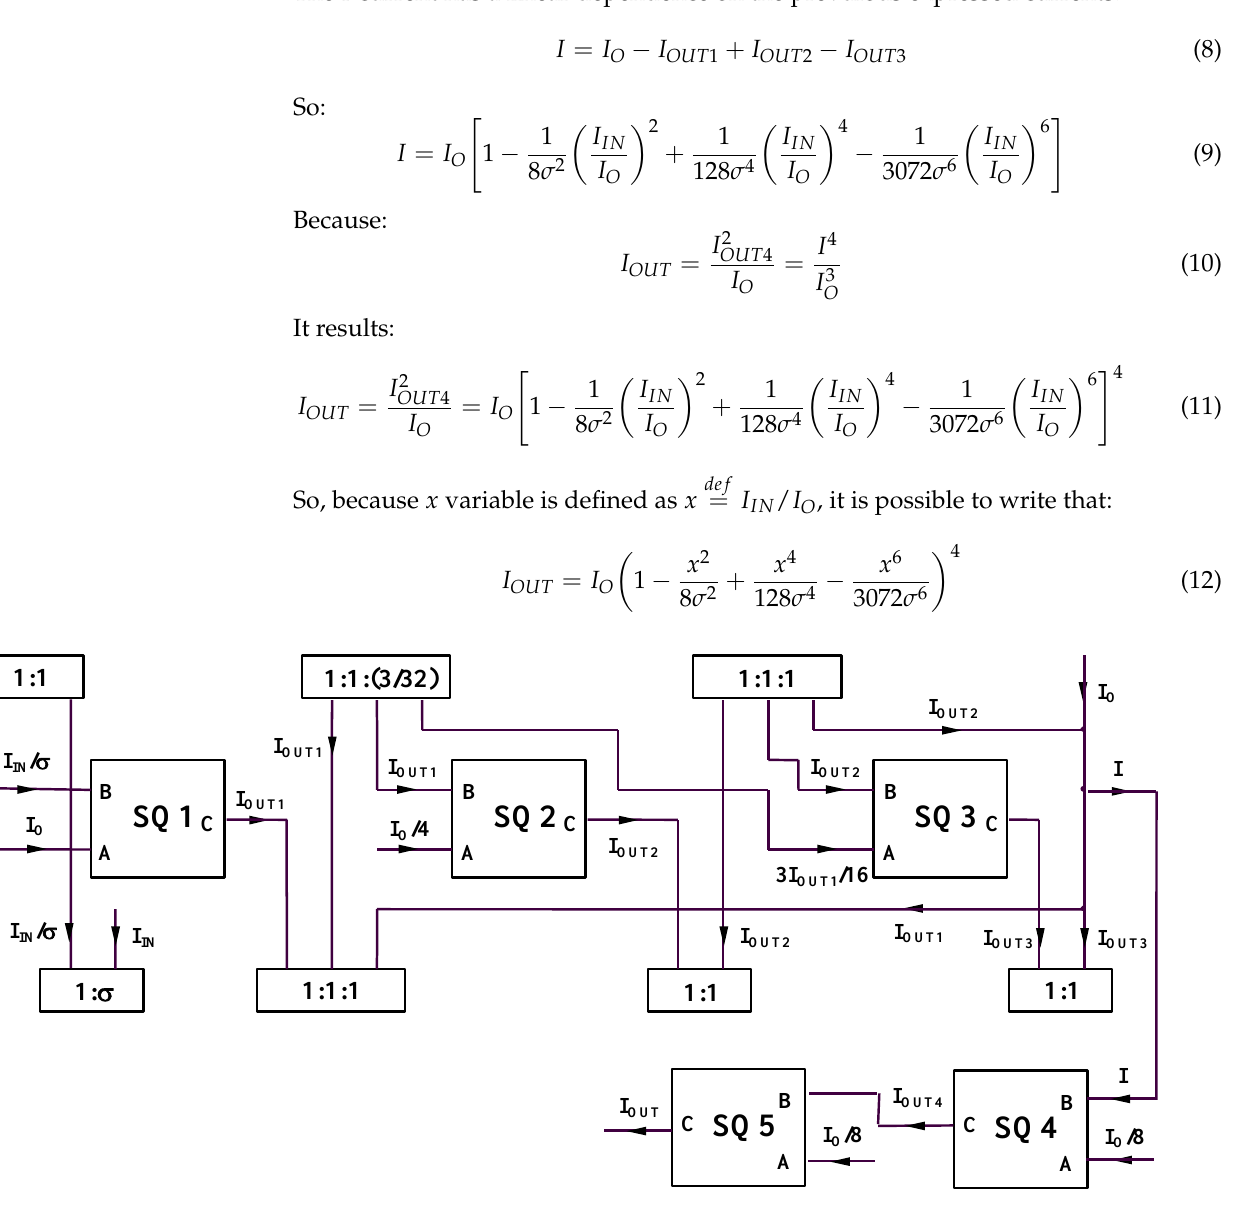
Figure 2. The squaring circuit (SQ).